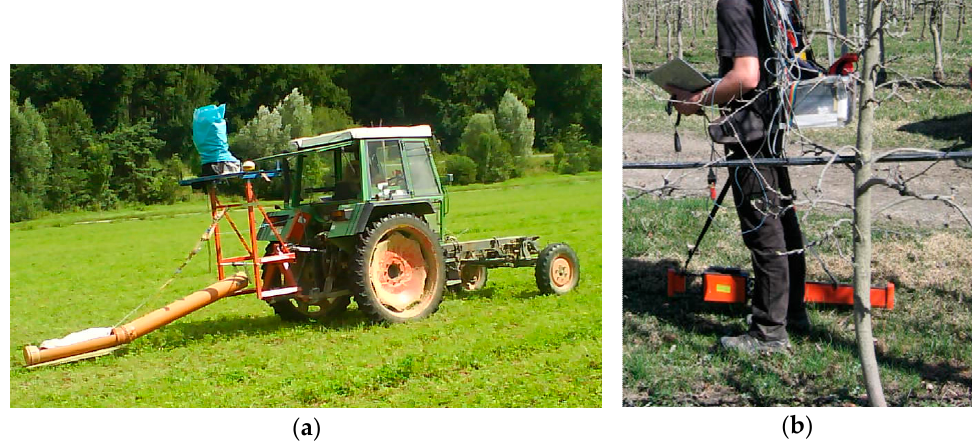
Figure 5. ( a ) EM38 mounted on a metal-free sledge pulled by a tractor (constructed after [44] Corwin. and Lesch 2005c); ( b ) hand guided measurement.